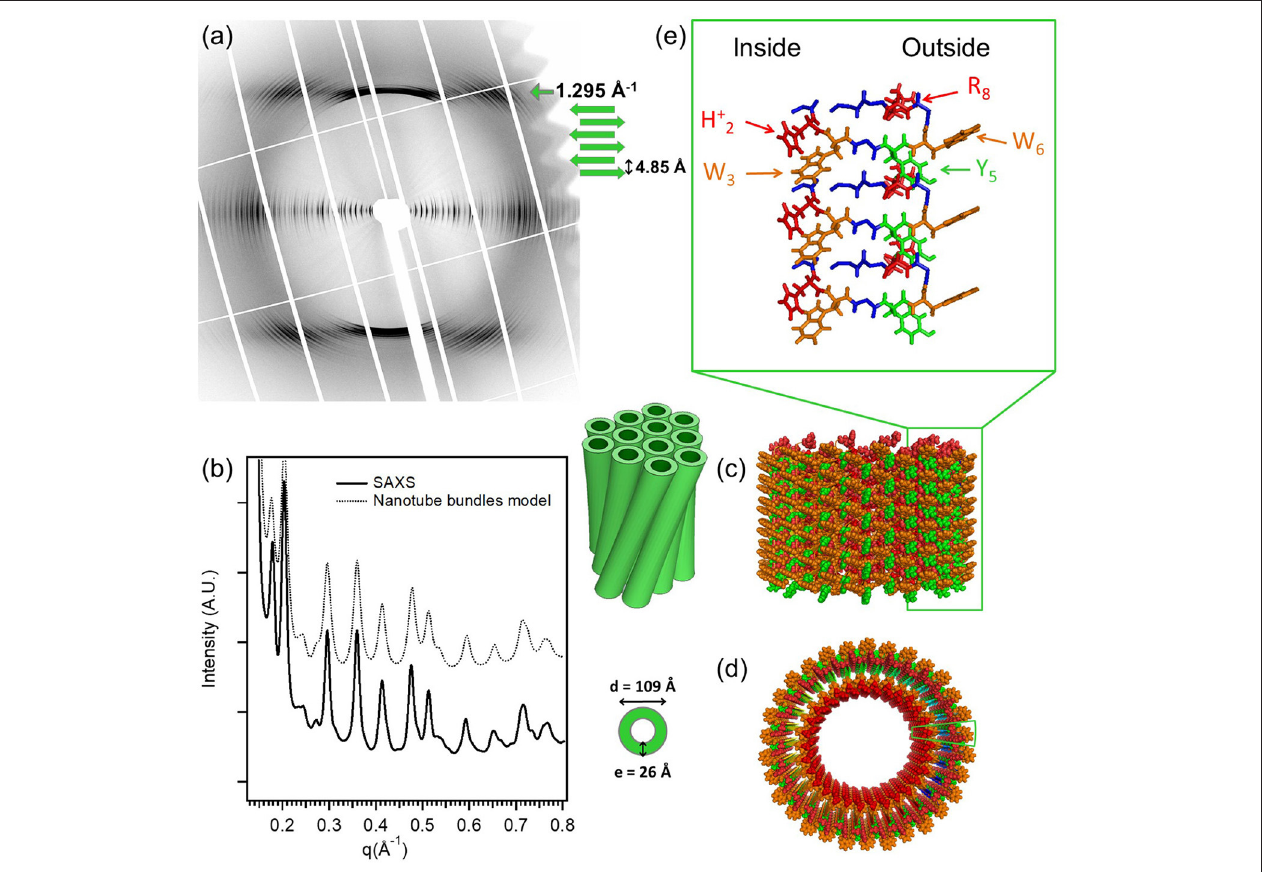
FIGURE 1 | The molecular structure of the low-pH triptorelin nanotubes. Aligned (a) fiber diffraction pattern and (b) SAXS profile of bundles of small nanotubes. (c) Side and (d) top schematic views of the small nanotubes built from 30 protofilaments. (e) Molecular structure of the protofilaments forming the nanotube walls. Color code: W (orange), Y (green), protonated histidine (H 2 ) + , and (R 8 ) + (red). The two green boxes in (c,d) underline the position of one protofilament that is enlarged in (e) . Reproduced from Valéry et al. (2015) licensed under a Creative Commons Attribution 4.0 International License.